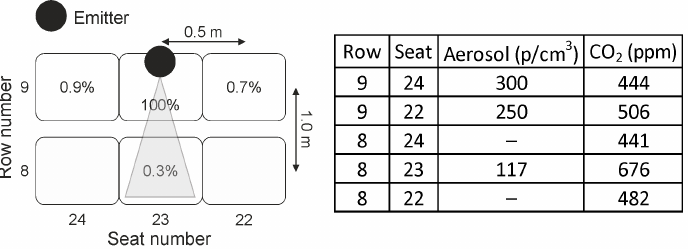
Figure 5. Schematic of seat positions for the dummy and measuring devices. The dummy is wear- ing a surgical face mask and emits aerosol with a concentration of 35,000 p/cm 3 and CO 2 of 5600 ppm. A horizontal temporarily fluctuating air flow with v H = 0.01 m/s was measured which is directed from the position of the dummy towards row 8/seat 22. The measured CO 2 and aerosol concentrations are summarized in the table.